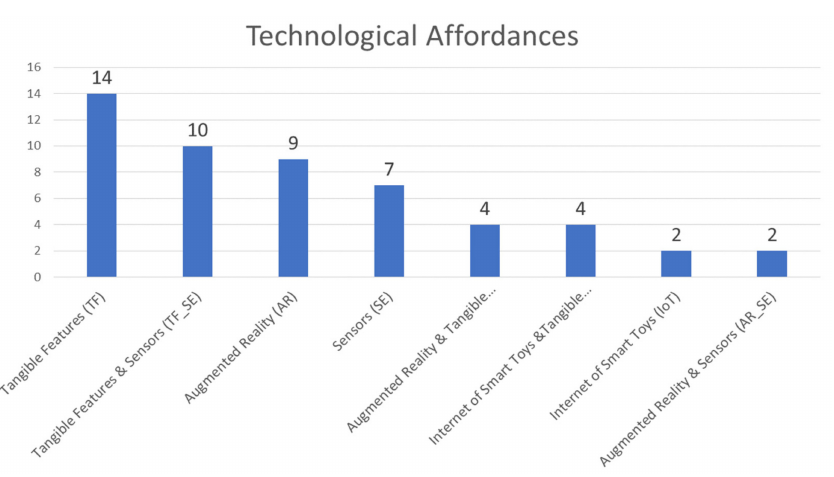
Figure 4. Technological affordances of smart